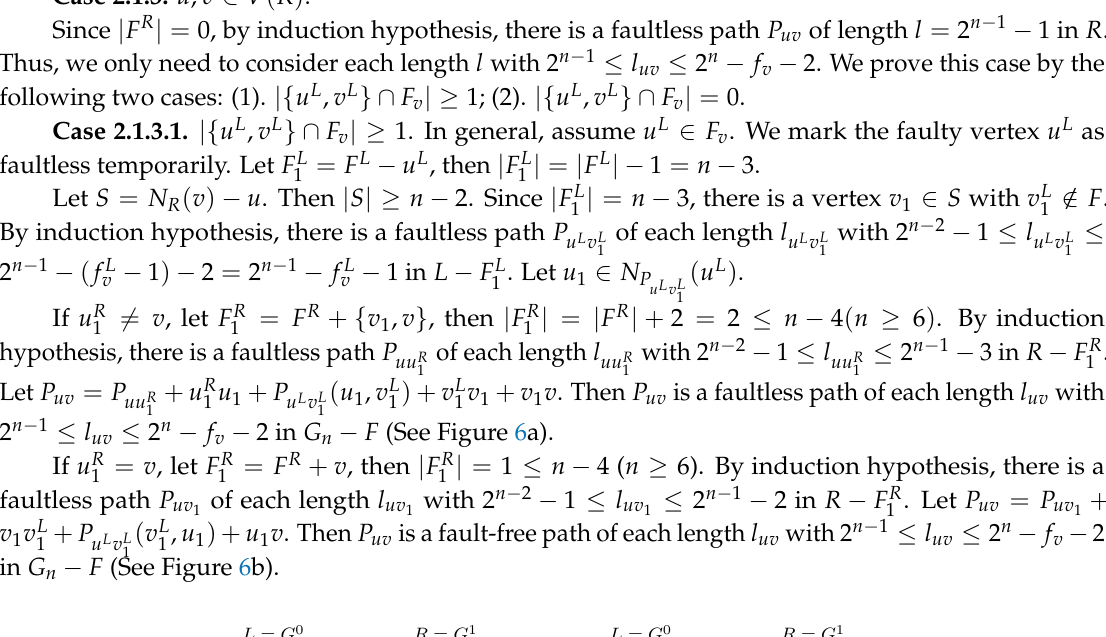
Figure 6. ( a ) Illustration of proof of u R Case